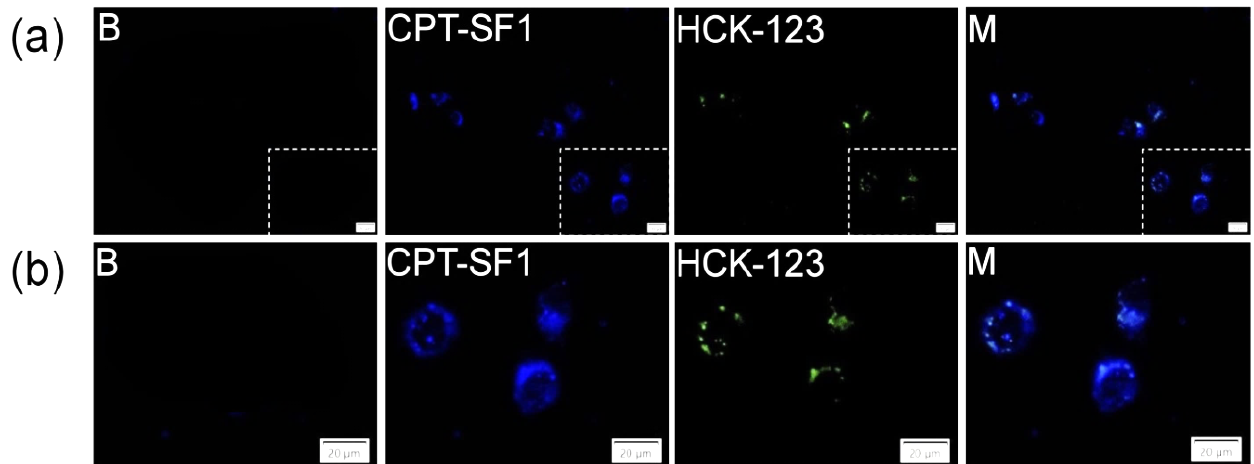
Figure 7. ( a ) MCF-7 cells fluorescence images and amplified area ( b ) of cells with LysoTracker (B), cells with 0.1 mg/mL of CPT–SF1, 50 nM of LysoTracker Yellow HCK-123 and combined pictures (M), scale bars are 20 µm (see structures in Figure 1).